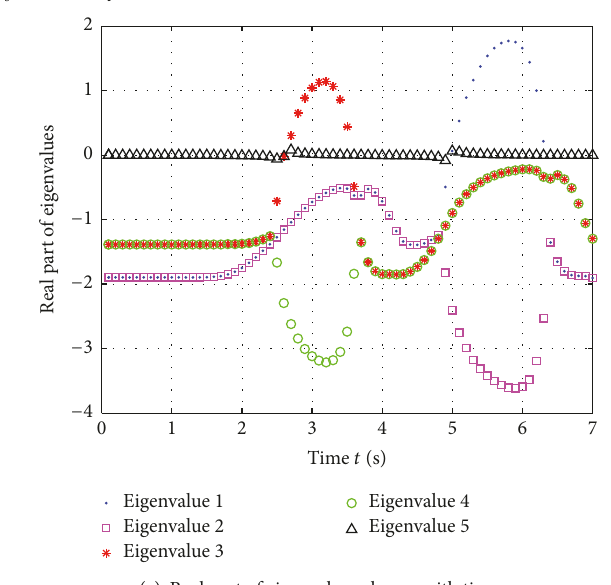
Figure 5: Changes in steering angle, lateral velocity, and calculated eigenvalues with 𝐴